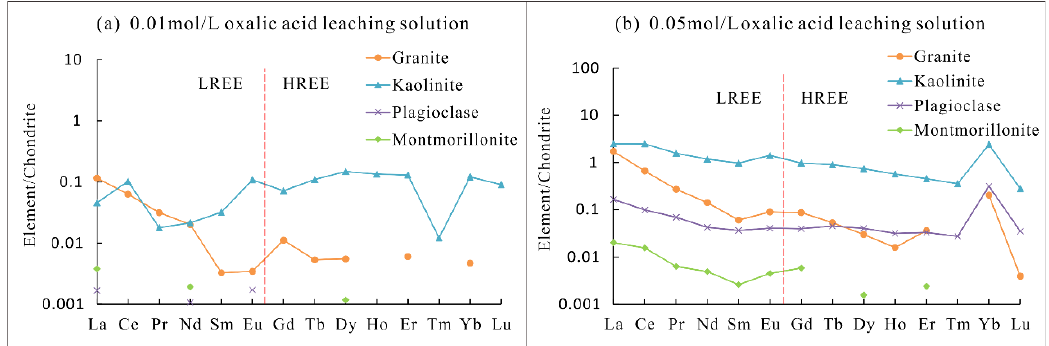
Figure 4. Chondrite - normalized patterns of dissolved REEs from minerals in oxalic acid leachates: Figure 4. Chondrite-normalized patterns of dissolved REEs from minerals in oxalic acid leachates: ( a ) 0.01 mol/L oxalic acid leaching solution ; ( b ) 0.05 mol/L oxalic acid leaching solution . ( a ) 0.01 mol/L oxalic acid leaching solution; ( b ) 0.05 mol/L oxalic acid leaching